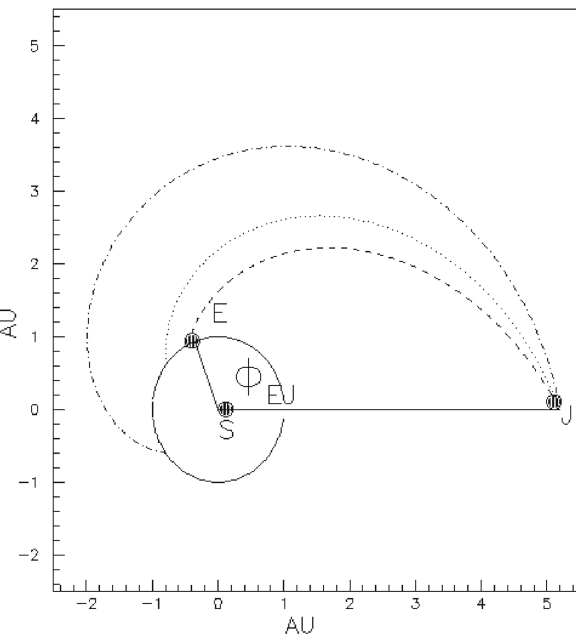
Fig. 1 A schematic view of Sun, Earth and Jupiter with the IMF lines connecting Jupiter with Earth, for V R = 400 km/s. The dashed line refers to γ = 0 . 57, the dotted line to γ = 0 . 37. The dot-dashed line refers to the Parker model. (We notice that the IMF lines based on measurements intersect the Earth orbit at angles Φ EJ < 180 ◦ )